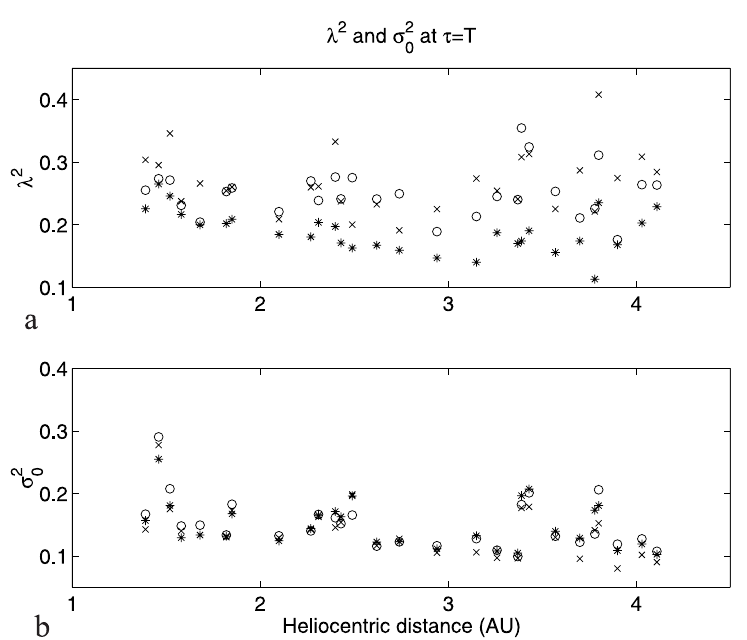
Figure 108: Values of 𝜆 2 (upper panel) and 𝜎 2 (lower panel) vs. heliocentric distance (see Section 9.2 for description of Castaing distribution and definition of 𝜆 and 𝜎 ). These values have been calculated for the projected low frequency beginning of the inertial range relative to each distance (see text for details). R, T, and N components are indicated by asterisks, crosses and circles, respectively. Image reproduced by permission from Pagel and Balogh (2003), copyright by